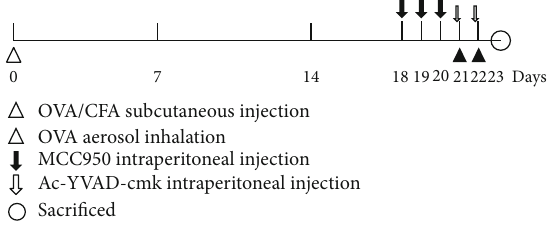
Figure 1: Ovalbumin sensitization, challenge, and intervention protocol. Balb/c mice were systemically sensitized by subcutaneous injection with OVA/CFA on day 0 and then challenged with OVA aerosols on days 21 and 22. MCC950 was administrated into mice by intraperitoneal injections for three consecutive days before the aerosols. Three hours before each exposure to aerosol, mice were injected intraperitoneally with Ac-YVAD-cmk. OVA: ovalbumin; CFA: complete Freund ’ s